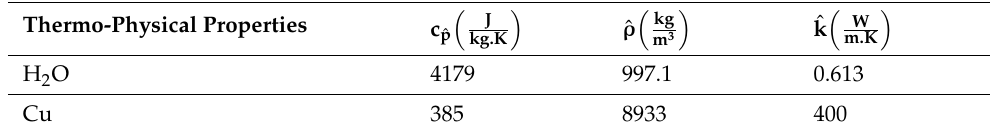
Table 1. Thermal and physical characteristics of copper and water. Thermo-Physical